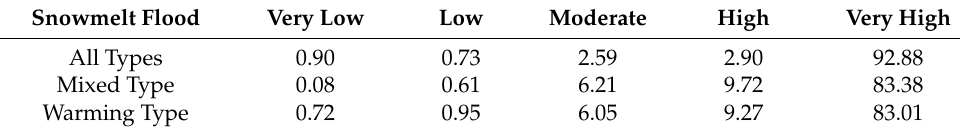
Table 5. Proportion of different snowmelt floods in each